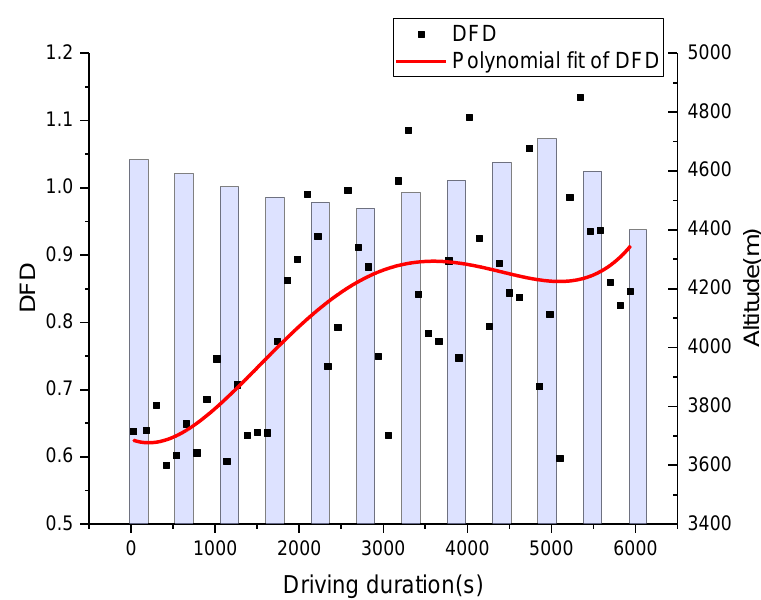
Figure 6. Variations of DFD with altitude and driving duration of segment 2.